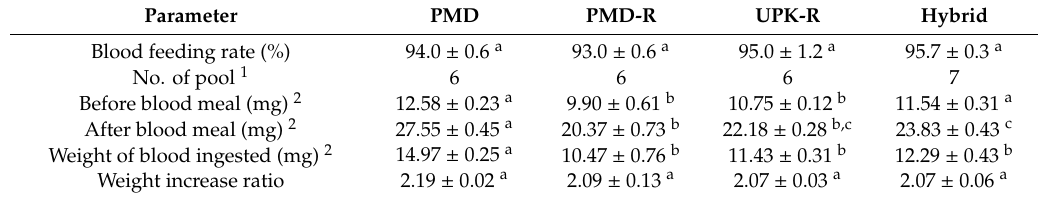
Table 2. Blood feeding capacity of the PMD, PMD-R, UPK-R, and F 1 (PMD-R × UPK-R) hybrid.